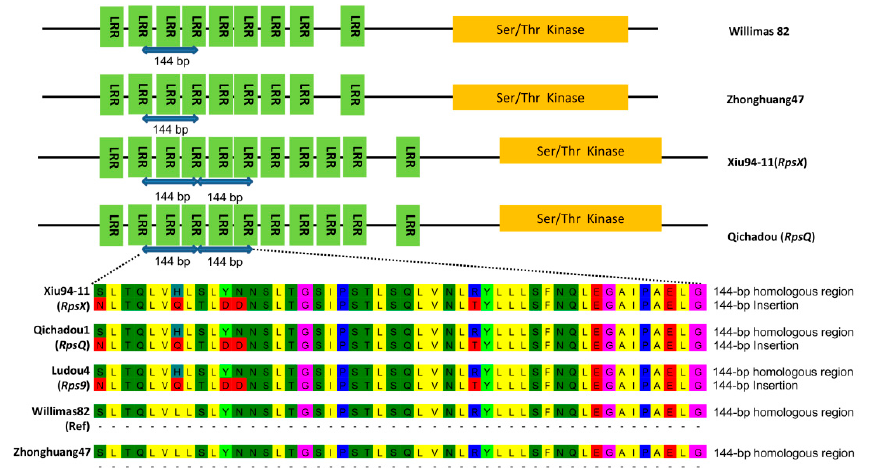
Figure 5. Analysis of conserved domains encoded by the alleles of soybean genotypes. The RpsX and RpsQ alleles contain a 144 ‐ bp insertion encoding 48 amino acid residues. This insertion is most similar to a 144 ‐ bp sequence upstream of the candidate gene.